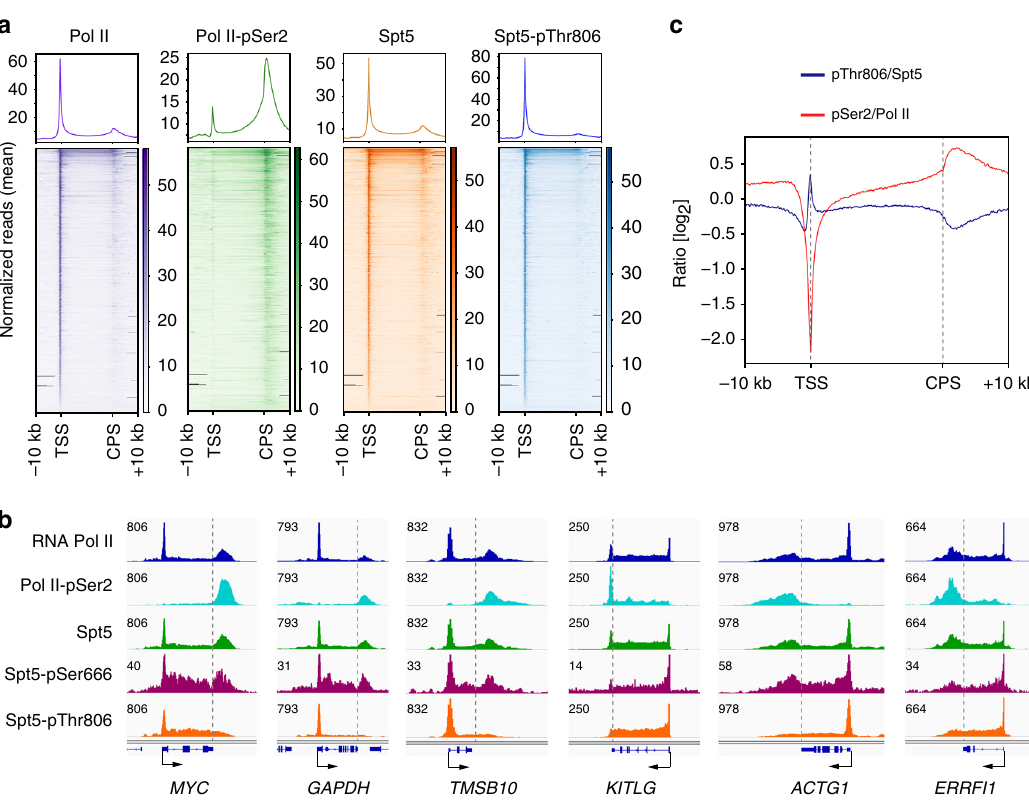
Fig. 2 Spt5 CTR1 becomes dephosphorylated downstream of the CPS. a Metagene analyses and heat maps of ChIP-seq data ( n = 20,130 genes) for total Pol II, pSer2, total Spt5, and Spt5-pThr806, as indicated ( n = 2 biological replicates). b Individual gene tracks of Pol II, Pol II-pSer2, Spt5, Spt5-pSer666, and Spt5-pThr806 ( y -axis scale indicated by number at top left of each track). c Metagene analysis of pThr806:Spt5 and pSer2:Pol II ratios ( n = 20,130